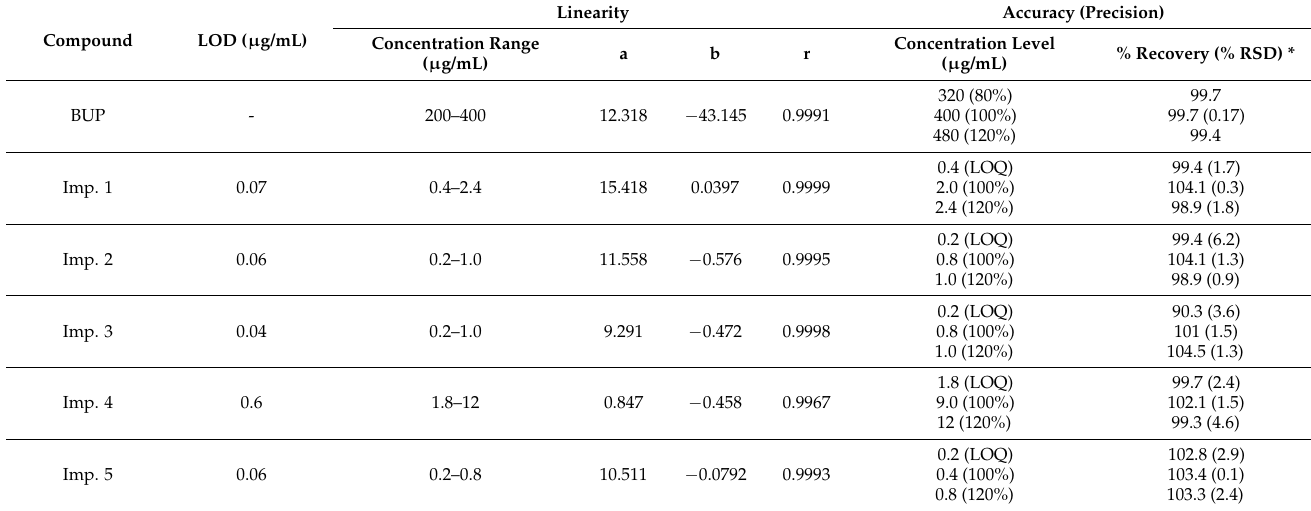
Table 4. Validation parameters: limit of detection, linearity, and accuracy of the proposed HPLC